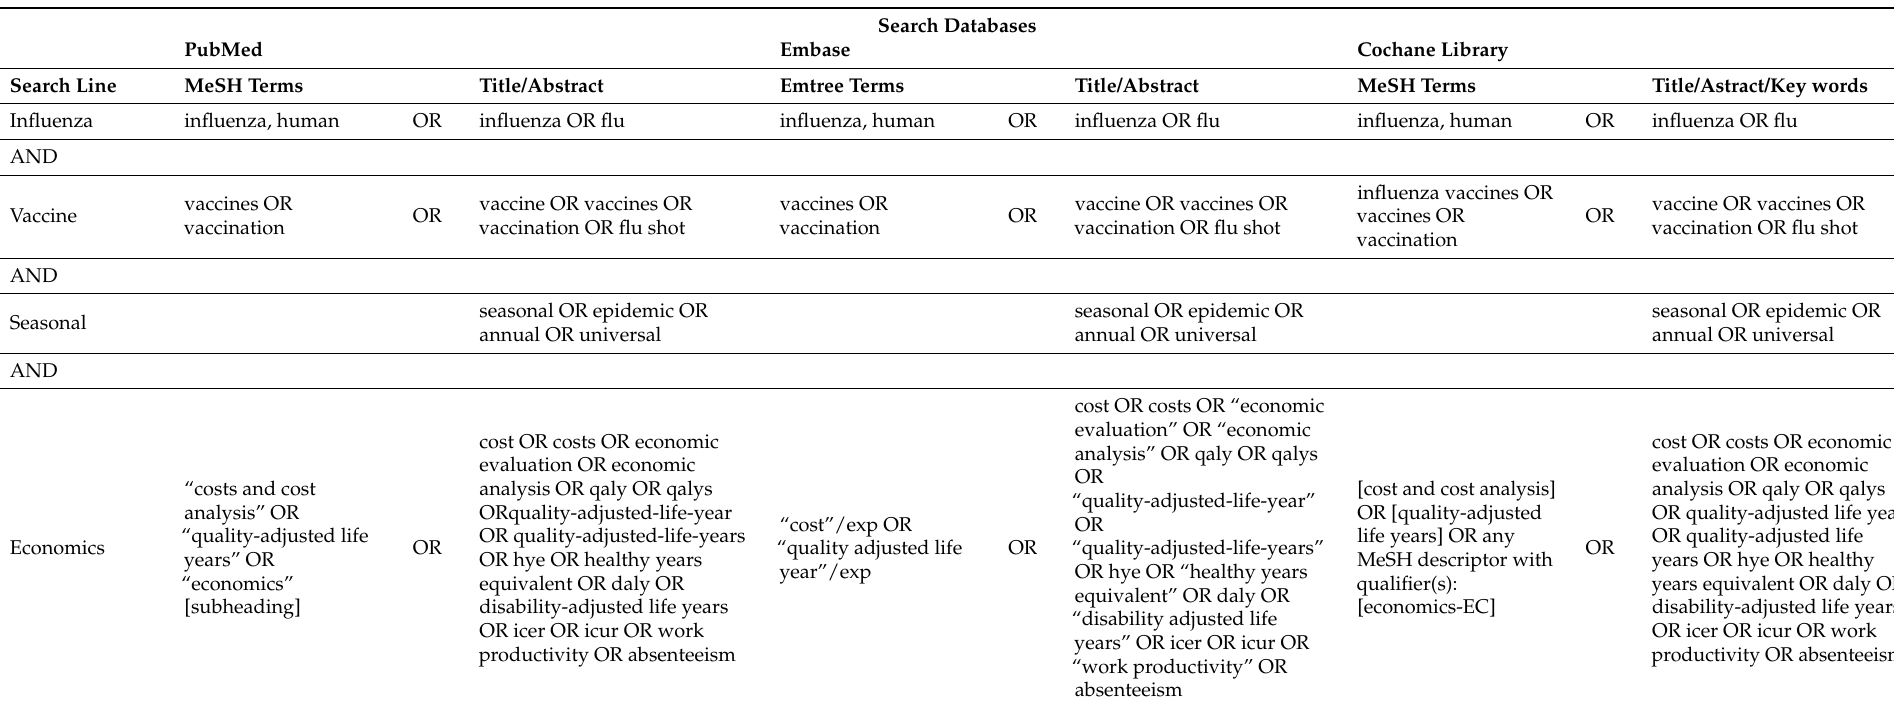
Table 1. Detailed search